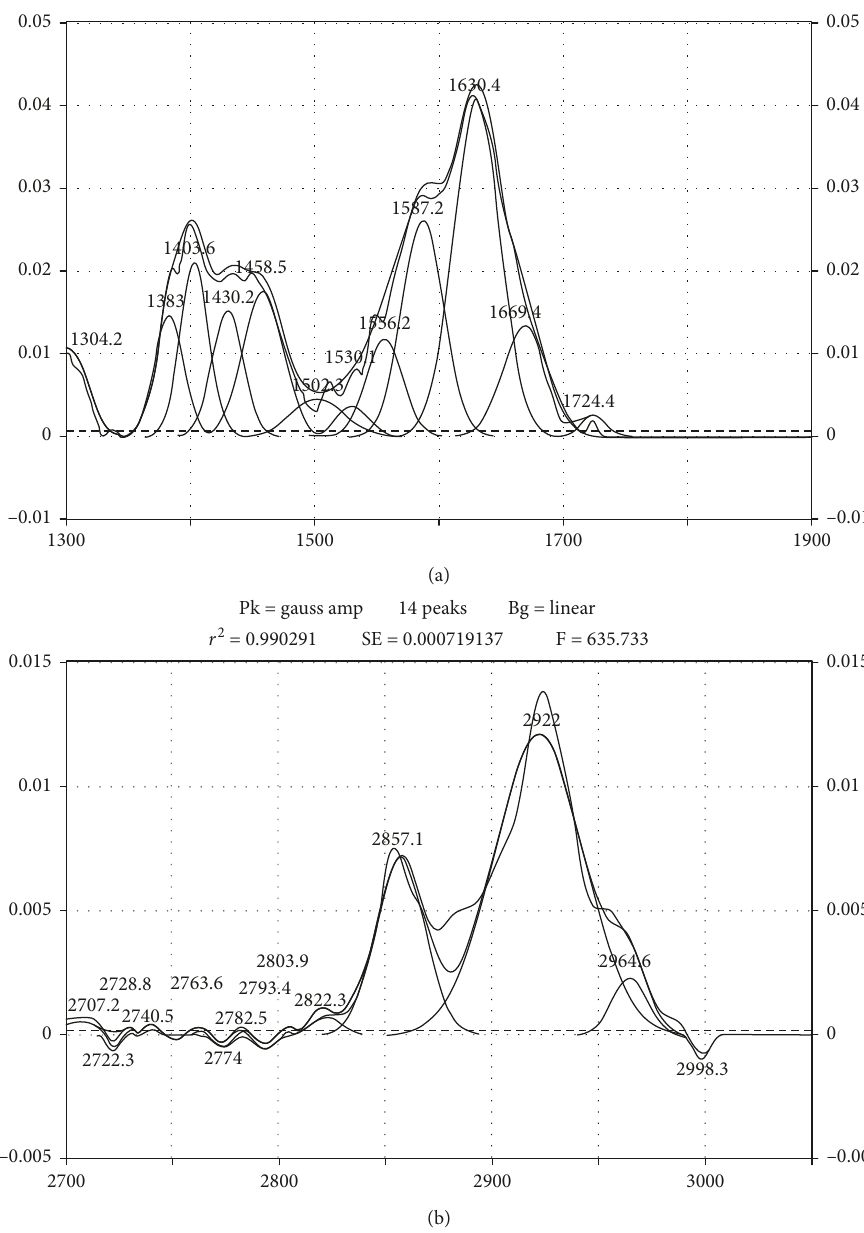
1 and 1300–1800cm 1 band for HB coal sample before − −